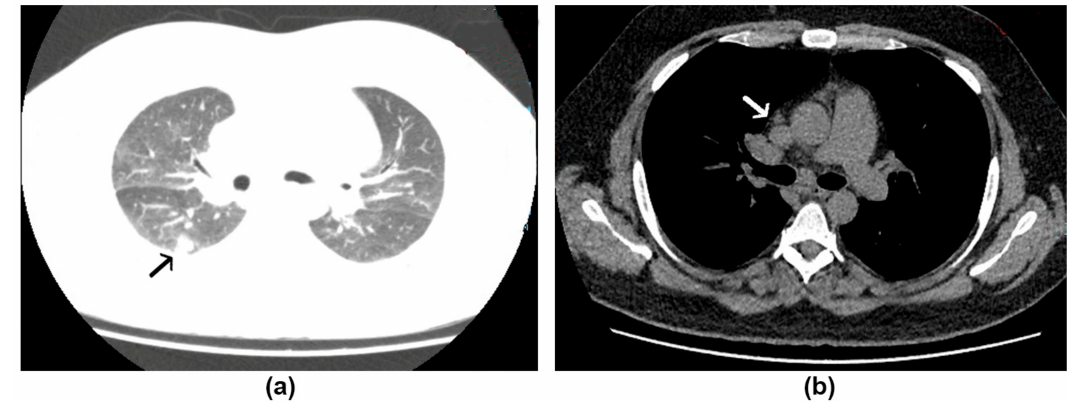
Figure 2. Chest tomography of case 2: ( a ) An irregular nodule (12 mm × 11 mm) of soft tissue density surrounded by ground-glass opacity in the superior segment of the right inferior lobe (black arrow); ( b ) lymph node enlargement (up to 21 mm × 16 mm) in the mediastinum and right pulmonary hilum (white